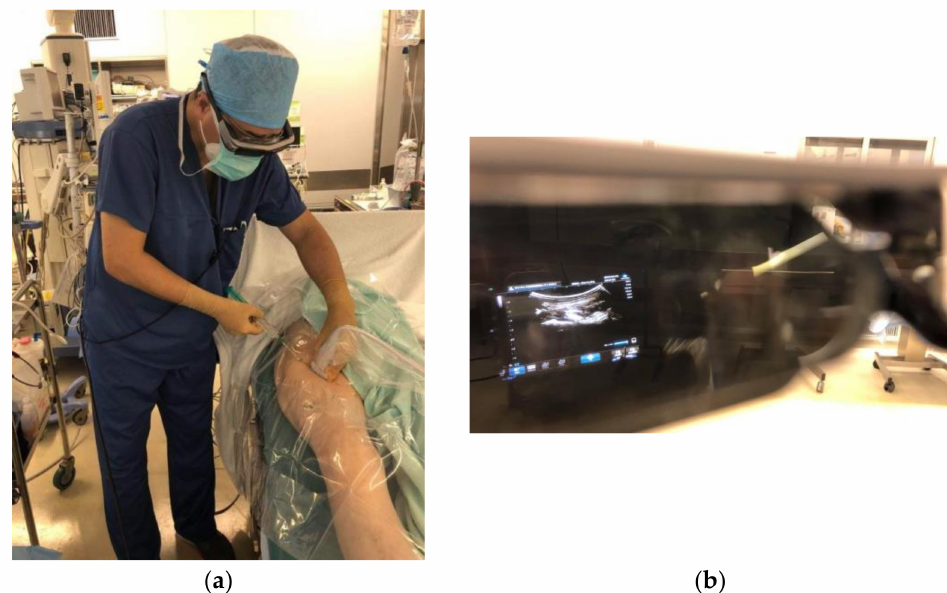
Figure 2. ( a ) Head-mounted display used while performing a femoral triangle block. Photo Credit: Tatsuo Nakamoto; Department of Anaesthesiology, Kansai Medical University; ( b ) The ultrasound image is displayed on the Epson Moverio BT-30E head-mounted display. Photo Credit: Tatsuo Nakamoto; Department of Anaesthesiology, Kansai Medical